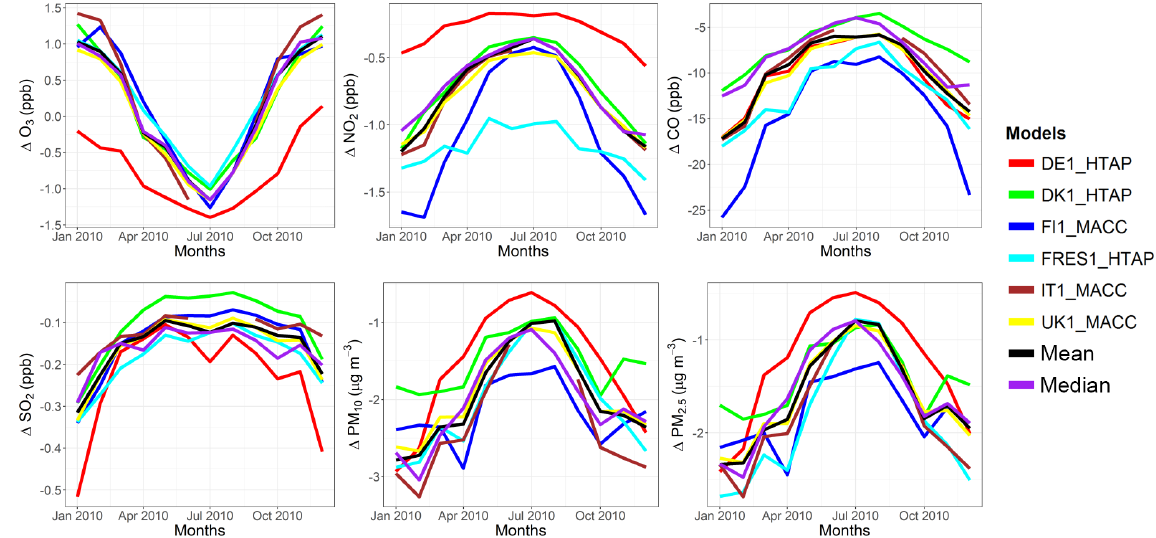
Figure 13. Absolute impact of the 20% reduction of the European anthropogenic emissions over Europe (EUR EUR − BASE EUR ).